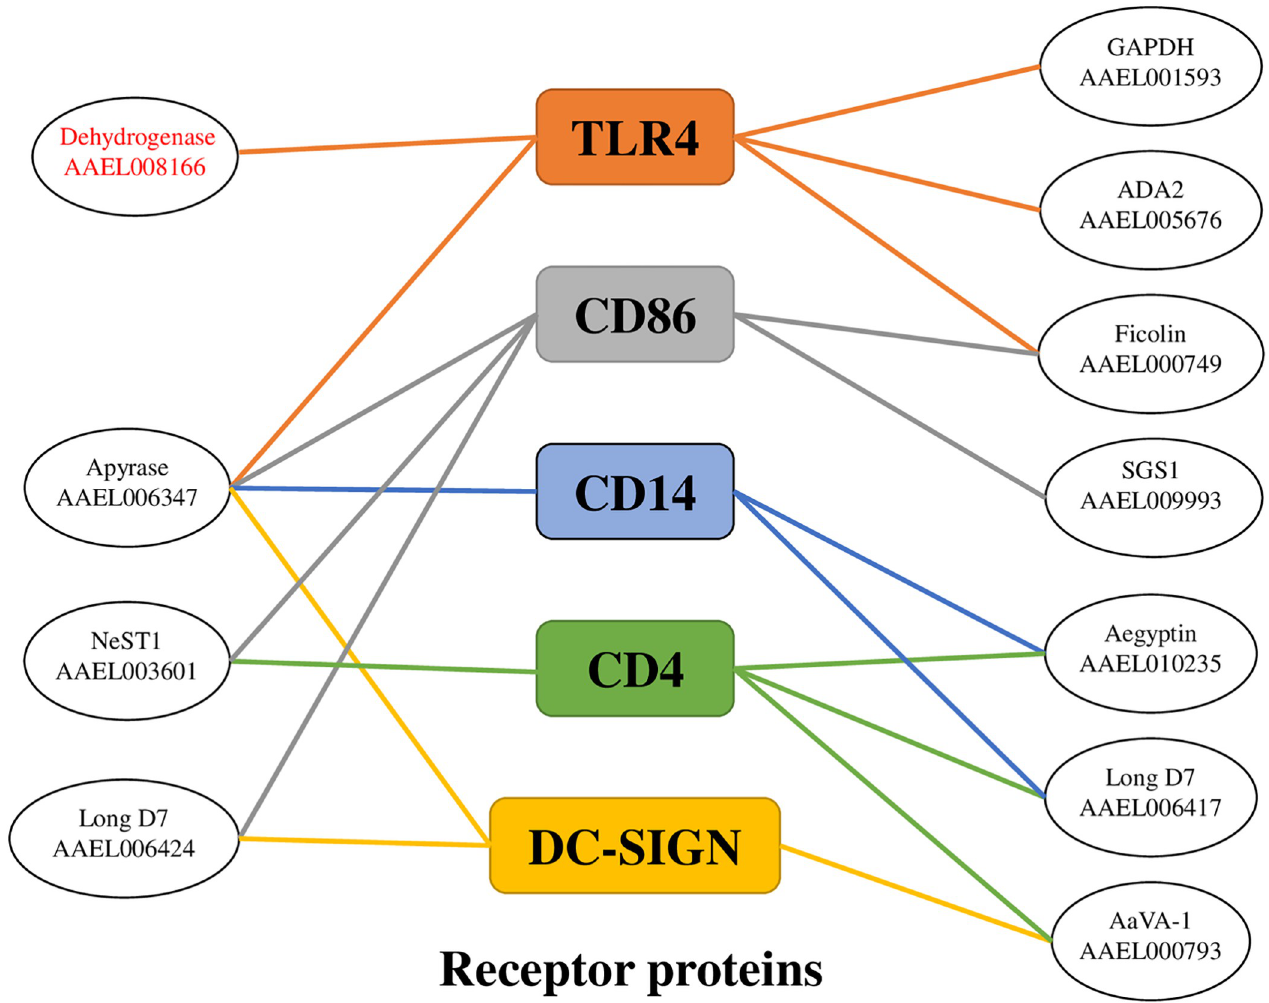
Fig 2. Human receptor proteins-SGPs interacting network. CD4, CD14, CD86, DC-SIGN and TLR4 are the human receptor proteins. All the SGPs identified here were previously reported to be present in the mosquito saliva [35]. Malate dehydrogenase (AAEL001593) has not been reported in the mosquito